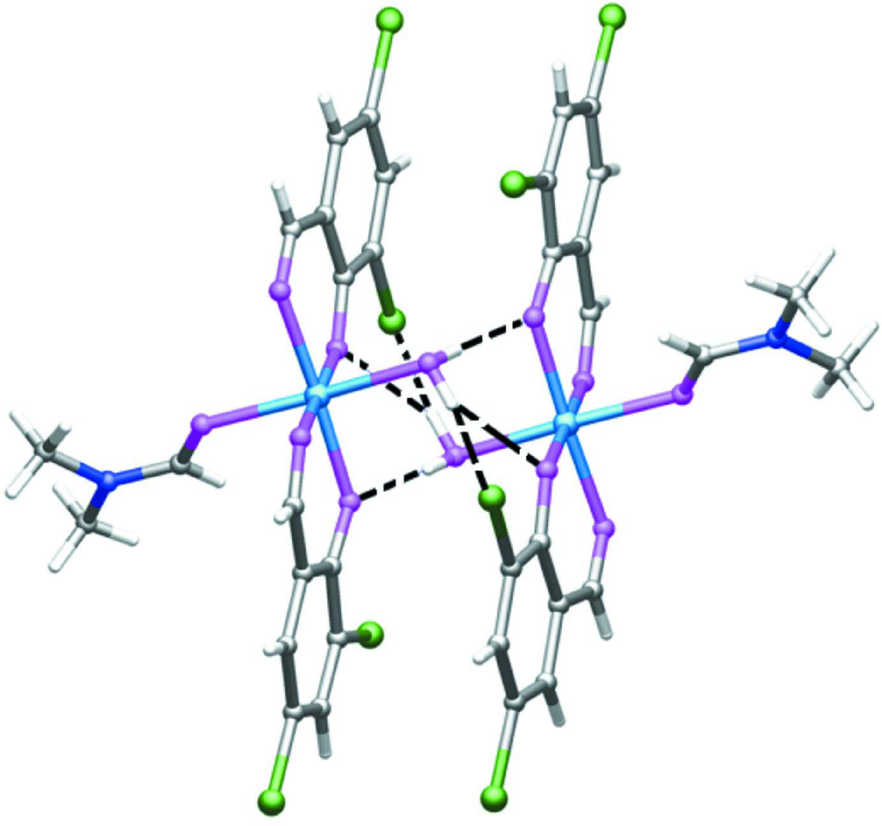
Figure 2 The dimer of (I), Dashed lines indicate hydrogen